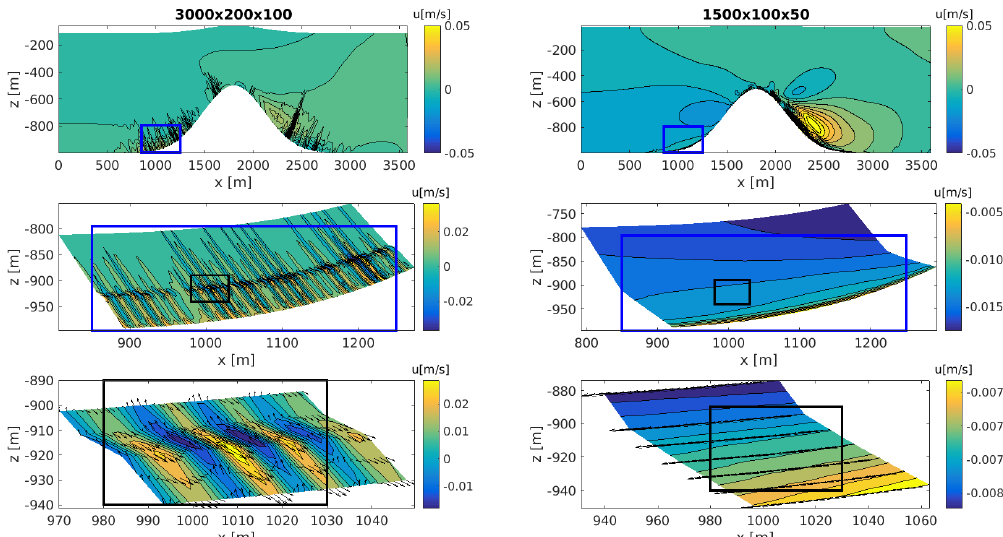
Figure 9. Figures depict zoomed-in details of the High ( left ) vs. Low ( right ) resolution side views of the stratified seamount experiment at t = 6000 s.